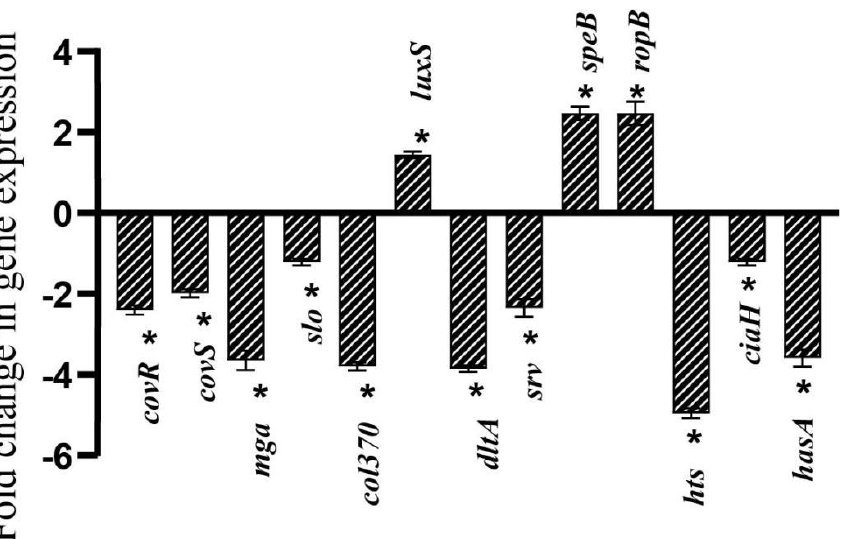
Figure 6. Linalool modulates virulence gene expression differentially. qPCR analysis of S. pyogenes ’ expression of biofilm- and virulence-related genes following a 24-h Linalool treatment. Data are represented as S.D. Asterisks denote statistical significance ( p < 0.05).